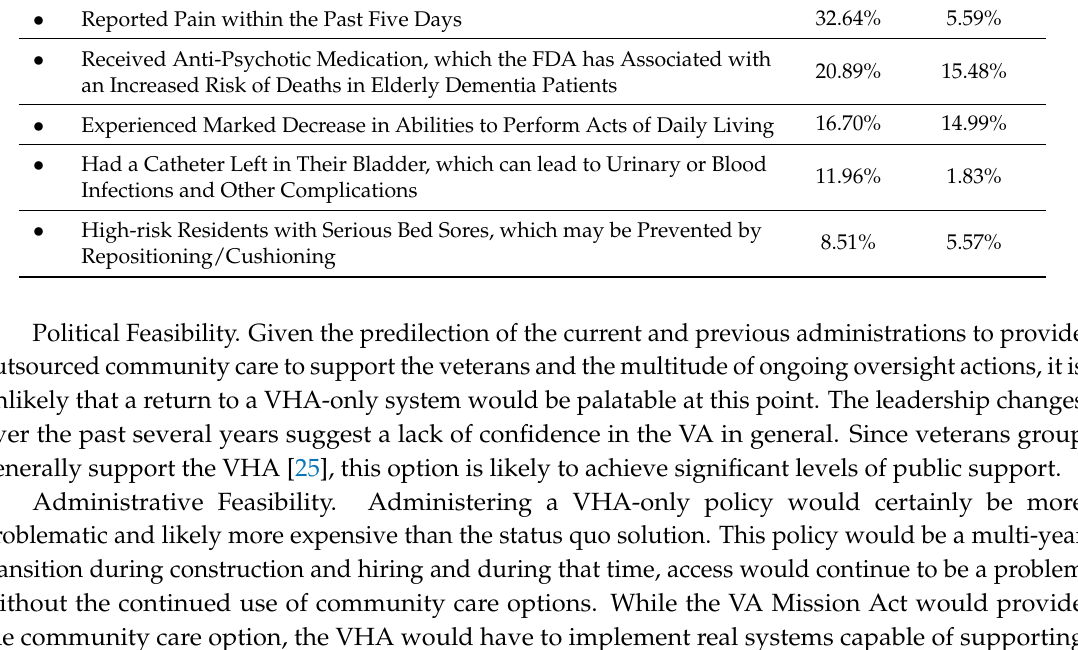
Table 3. The 2017 quality care comparison for nursing homes does not reflect case complexity; however, certain measures such as the administration of anti-psychotics, catheter mistakes and decubitus ulcers are problematic. Measure VHA Non-VHA